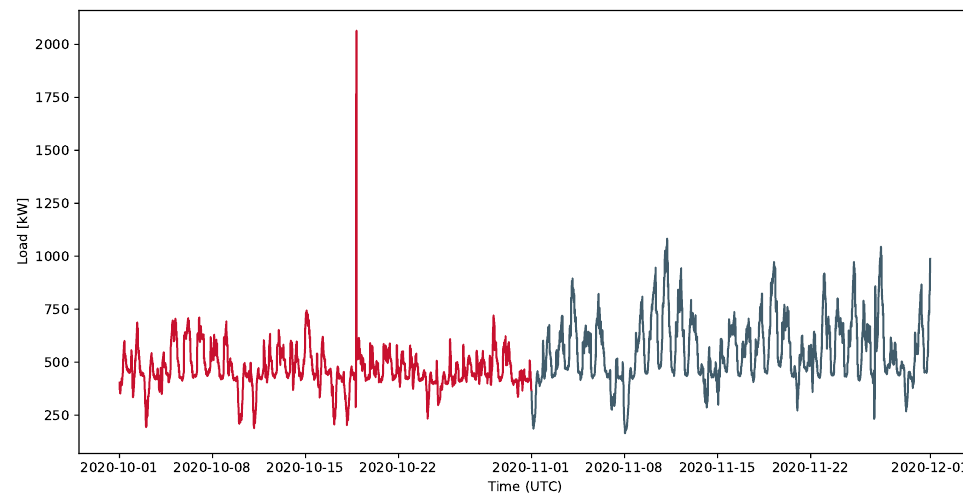
Figure 7. Base load in October 2020 (red) and November 2020